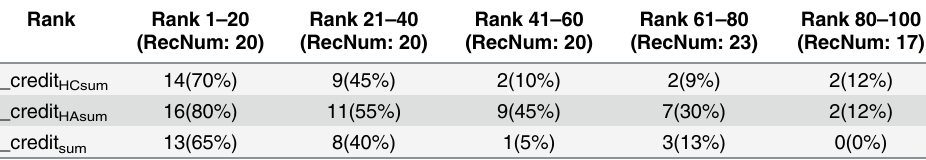
Table 3. Segmented counts of the 100 top-ranked authors based on harmonic_credit. Rank